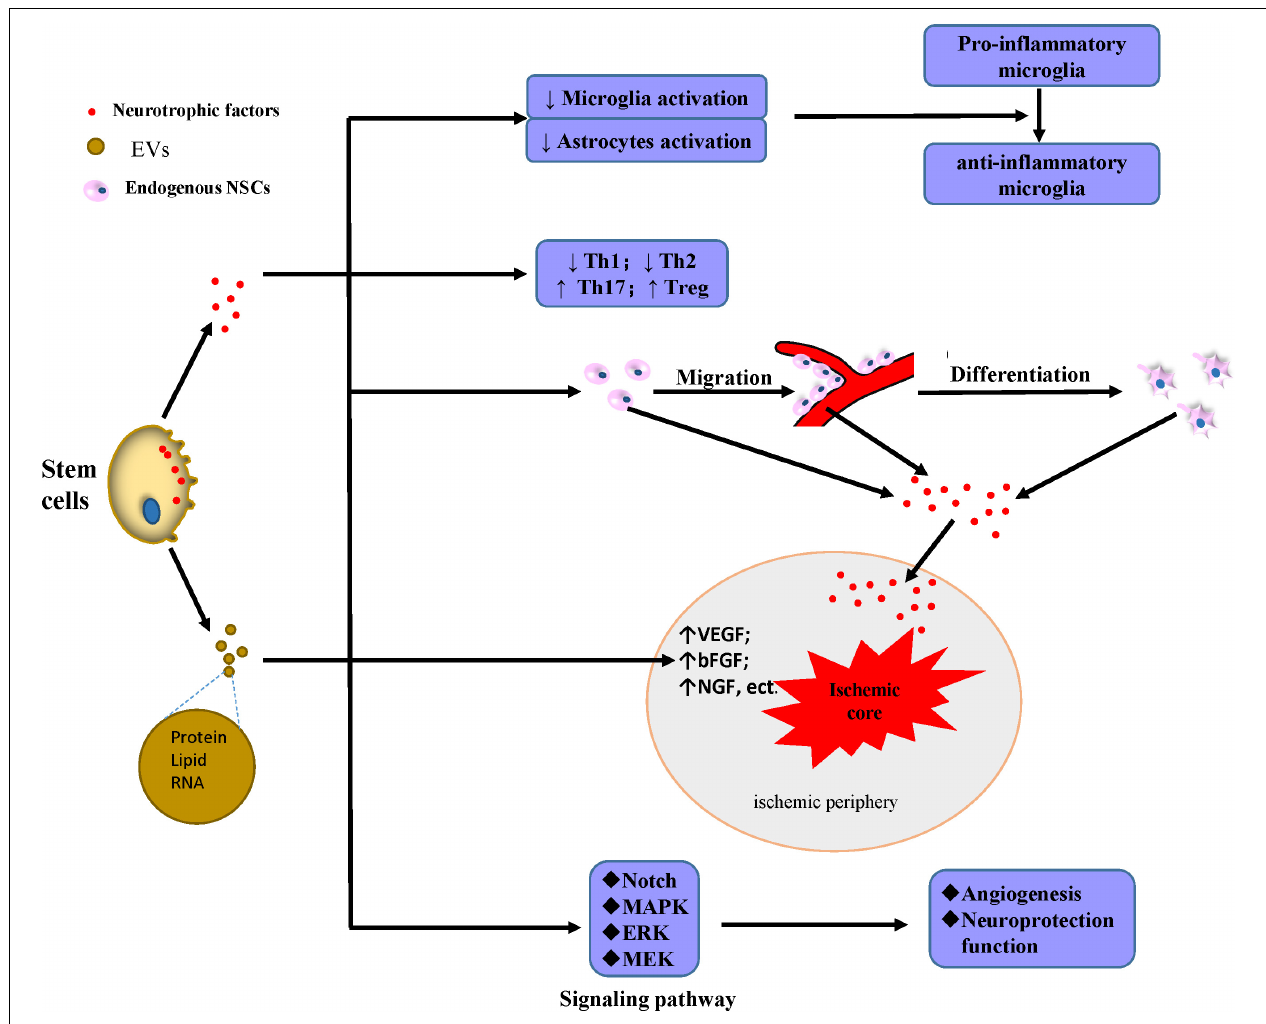
FIGURE 3 | Mechanisms of secretion of protective factors. Stem cells secrete neurotrophic factors or generate EVs mainly containing proteins, lipids, and RNA with multiple neuroprotective effects: inhibiting the activation of microglia and astrocyte, and also promoting microglia shift to the anti-inflammatory phenotype instead of the pro-inflammatory; downregulating Th1 and Th2 and upregulating Th17 and Treg; promoting the migration, differentiation, and secretion of neurotrophic factors to the ischemic periphery; upregulating the content of many factors including VEGF, bFGF, and NGF in the ischemic periphery; and mediating angiogenesis and neuroprotection through the induction of MEK/ERK/MAPK and Notch signaling pathway. Abbreviations: ↑ , upregulation; ↓ , downregulation; EVs, extracellular vesicles; NSCs, neural stem cells; Th, T helper cells; Treg, regulatory T cells; VEGF, vascular endothelial growth factor; bFGF, basic fibroblast growth factor; NGF, nerve growth factor; MAPK, mitogen-activated protein kinase; ERK, extracellular signal-regulated kinase; MEK, MAP